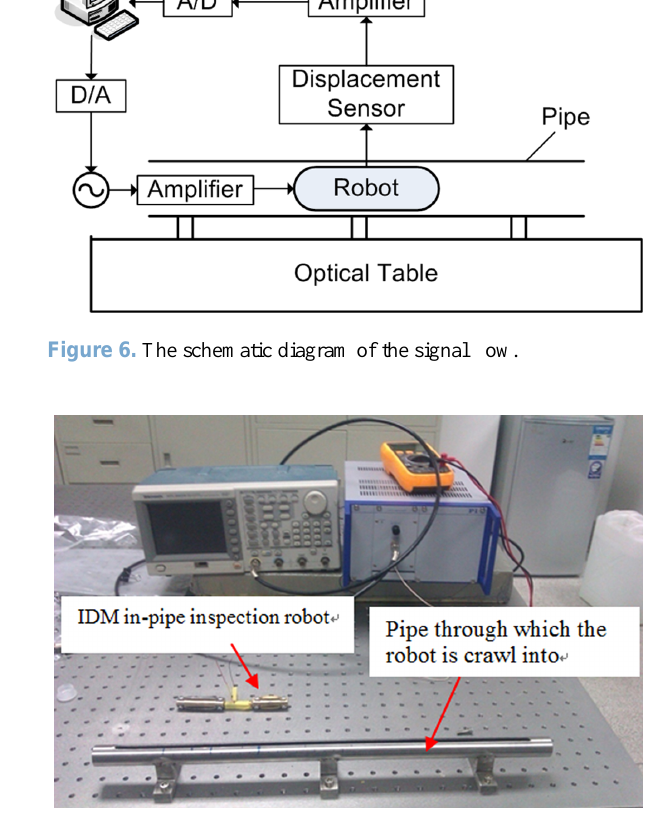
Figure 5. Displacements of Object A and block in 5 cycles.